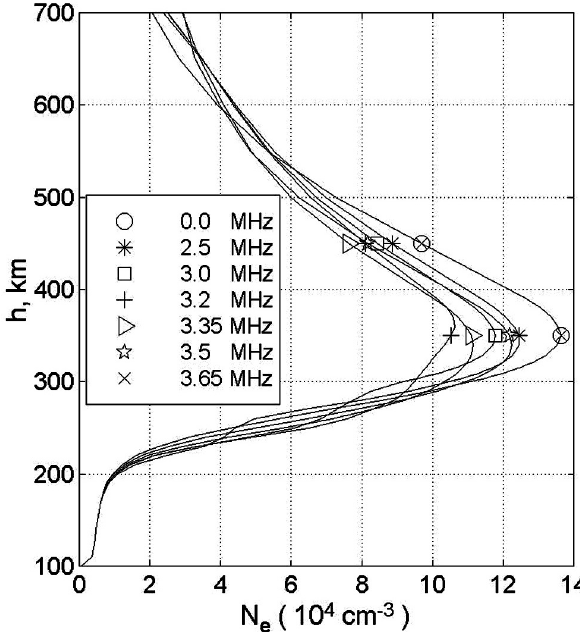
Fig. 5. The variations of the electron temperature (in absolute de- grees) along the considered part of the convection trajectory at level h = 350km. The results are given for different HF wave frequen- cies: 2.5, 3.0, 3.2, 3.35, 3.5, and 3.65MHz. The results, obtained under natural conditions without a powerful HF wave effect, are indicated by symbol